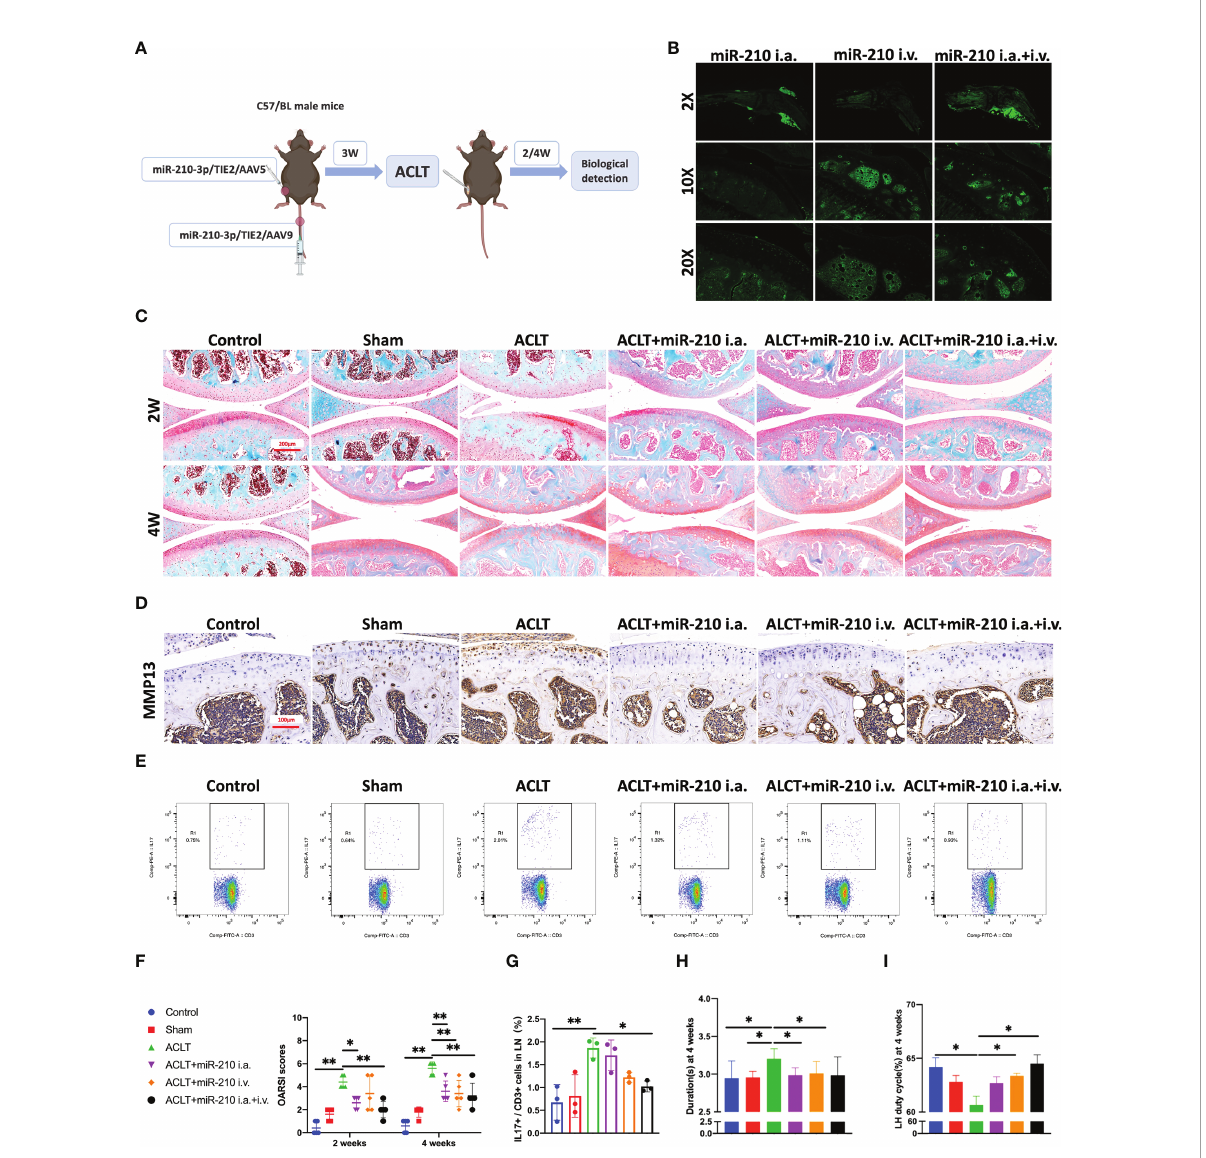
FIGURE 6 miR-210-3p overexpression induced by AAV attenuates OA progression. (A) Design of animal experiments. C57BL/6 mice were i.a. or i.v. injected with miR-210-3p/TIE2/AAV. ACLT was performed to induce posttraumatic OA 3 weeks after AAV administration. Biological and behavioral tests were performed at 2 and 4 weeks after ACLT. (B) Representative photos of Zsgreen fl uorescence in the affected knees of mice from miR-210-3p/TIE2/AAV i.a., i.v. and i.a.+i.v. injected group. (C) Representative images of safranin-O & fast green staining of LH knee joints in each group at 2 weeks and 4 weeks. Scale bar: 200 m m. (D) Representative images of immunohistochemical staining for MMP13 in cartilage and subchondral bone of the tibial plateau in each group at 4 weeks. Scale bar: 100 m m. (E, G) Flow cytometry images and quanti fi ed results for IL- 17 + /CD3 + cells in inguinal lymph nodes at 2 weeks after ACLT. (F) OARSI scores of LH knees from each group. (H, I) Durations and LH duty cycle of each group at 4 weeks after ACLT. ** P < 0.01. * P < 0.05. LN, lymph nodes. LH, left hindlimb. All data are presented as the means